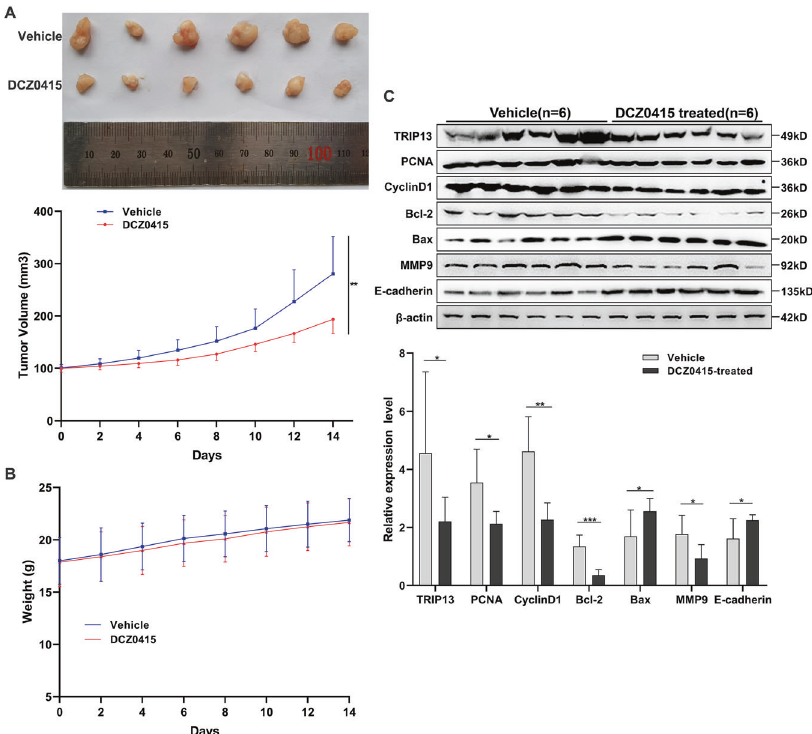
Fig. 6 DCZ0415 inhibited HCT116 xenograft tumor growth in nude mice. A Effect of DCZ0415 on tumor volume. B Body weight in HCT116 human CRC xenograft tumor model after treatment. C DCZ0415-treated tumors showed similar changes in expression of TRIP13, PCNA, Cyclin D1, Bax, Bcl-2, MMP9, and E-cadherin as those in the DCZ0415-treated CRC cells. * p < 0.05, ** p < 0.01, *** p <